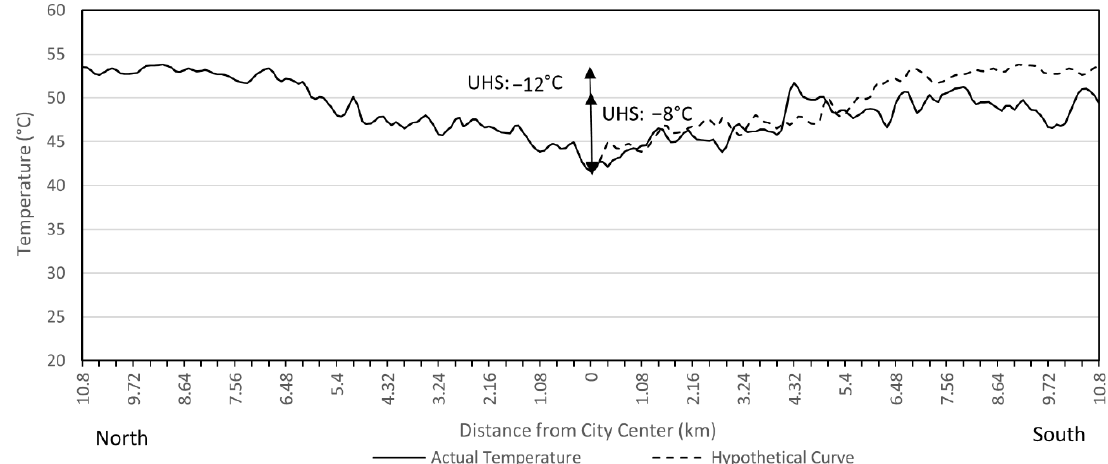
Figure 12. Surface temperature cross section along a north-south transect across the city of Marrakech.